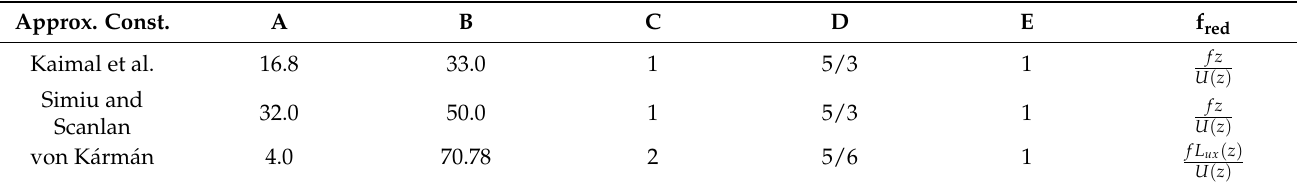
Table 2. Approximation constants (A–E) and reduced frequency (f red ), according to Kaimal et al. [39], Simiu and Scanlan [40], and von K á rm á n [41]. Adapted from